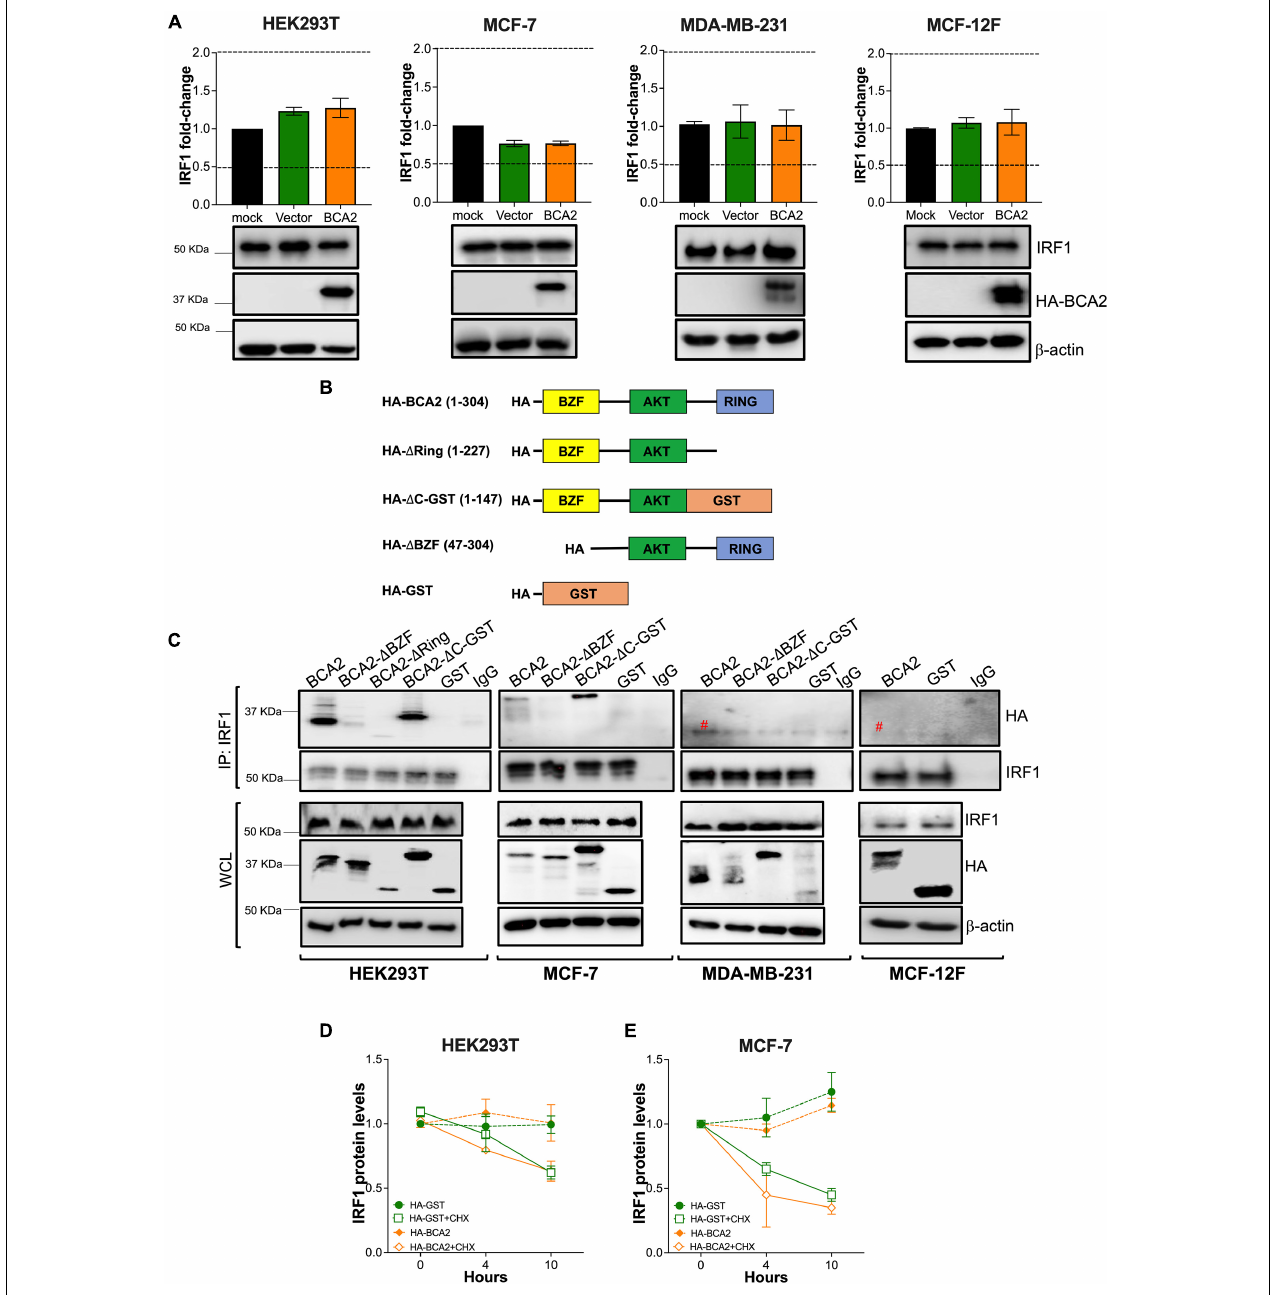
FIGURE 7 | BCA2 uses its Zinc-finger domain to interact with IRF1 in HEK293T and MCF-7 cells. The hypotheses formulated in Figure 6 were tested in HEK293T, MCF-7, MDA-MB-231, and MCF-12F cells. (A) The effects of up-regulating BCA2 on IRF1 gene expression was assessed by RT-qPCR and western blot. Dotted lines represent threshold for biological significance. Data correspond to the mean and SEM of 3 independent experiments. Up-regulation of BCA2 and endogenous IRF1 levels were verified by western blot (bottom panels). (B) Diagram of the BCA2 truncation mutants that were generated to test models (on Figures 6B,C ). The numbers in brackets indicate the BCA2 residues present in each mutant. (C) BCA2-IRF1 binding was investigated in all the cell lines by immunoprecipitating endogenous IRF1 and assessing the presence of the HA-tagged constructs presented in panel B in the pulldown fraction. The levels of expression of IRF1, the BCA2 truncation constructs and β -actin were examined from the whole cell lysates (WCL). Red pound symbol indicates bands corresponding to the light chain of the antibody used in the IP. Blots are representative of 3 independent experiments. (D,E) The effect of HA-BCA2 and HA-GST (irrelevant protein) on IRF1 protein stability was investigated in HEK293T and MCF-7 cells in the presence and absence of cycloheximide (CHX), a translation inhibitor. Samples were collected over the course of 10 h after DMSO or CHX treatment. The expression or IRF1 over β -actin and relative to the zero time-point was calculated by densitometry analyses and plotted as IRF1 relative levels. Data correspond to the mean and SEM of 3 independent